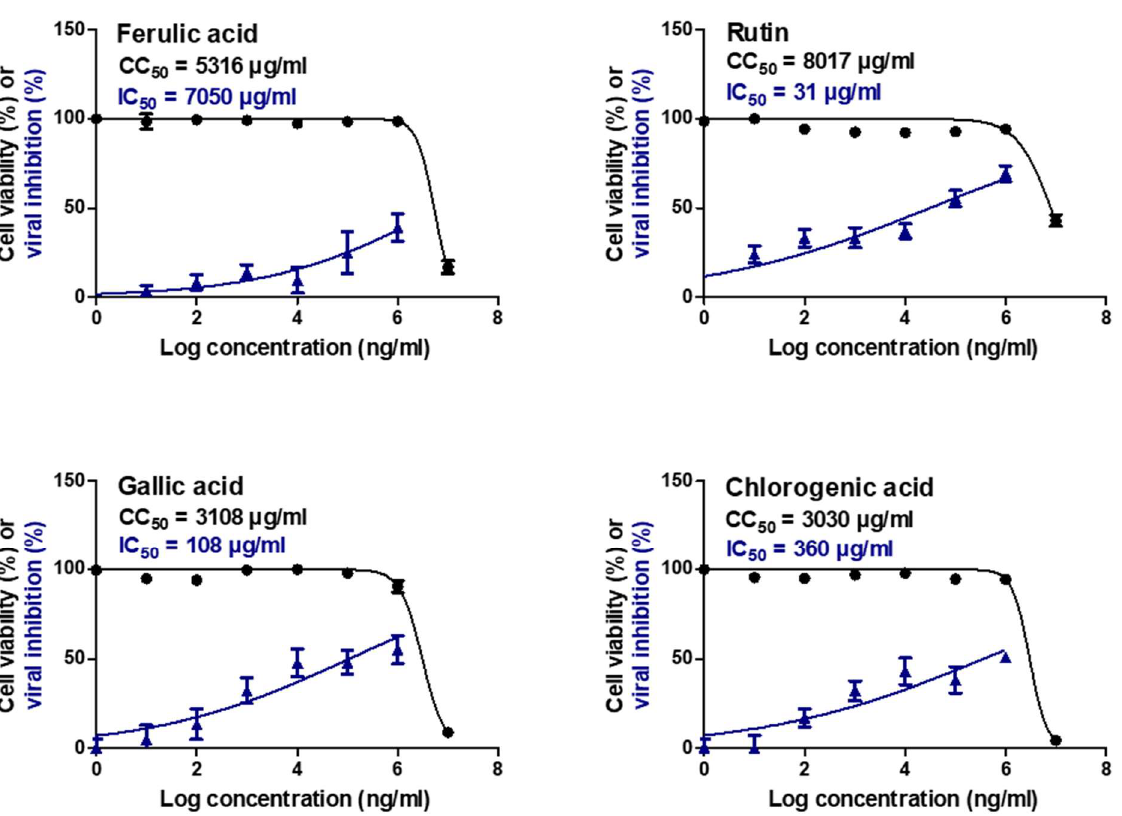
Table 4. Cytotoxicity and virus-inhibitory effect of the isolated compounds (1–4) against SARS-CoV-2. Compound